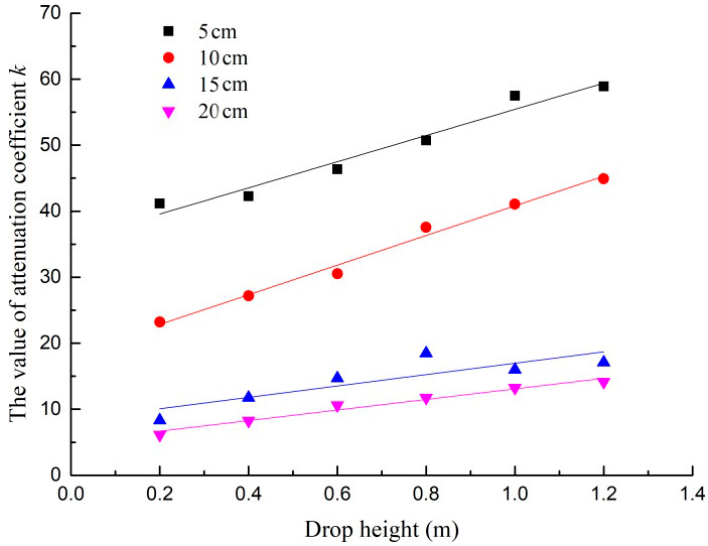
Figure 9. The change of the attenuation coefficient k of the vertical peak particle velocity with impact height under different thicknesses of concrete slabs.